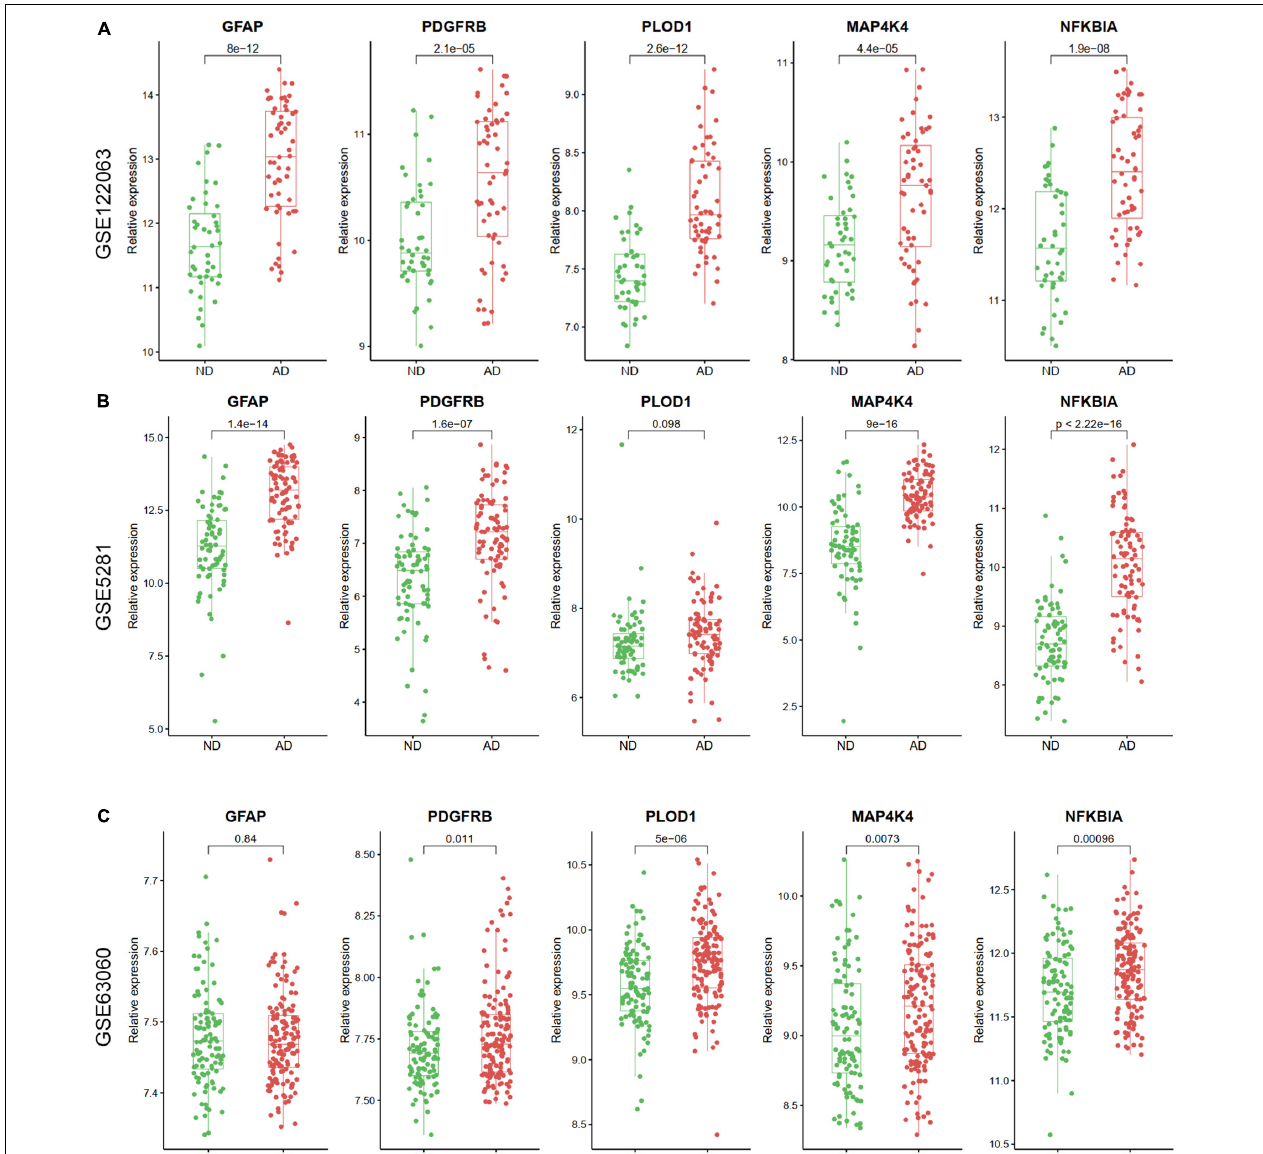
FIGURE 8 | The relative expression levels of five hub ARDEGs in GSE122063 (A) , GSE5281 (B) , and GSE63060 (C) with box and scatter plots. Except for the expression of PLOD1 in GSE5281 and GFAP in GSE63060 did not show significant differences, the other genes were increased in AD